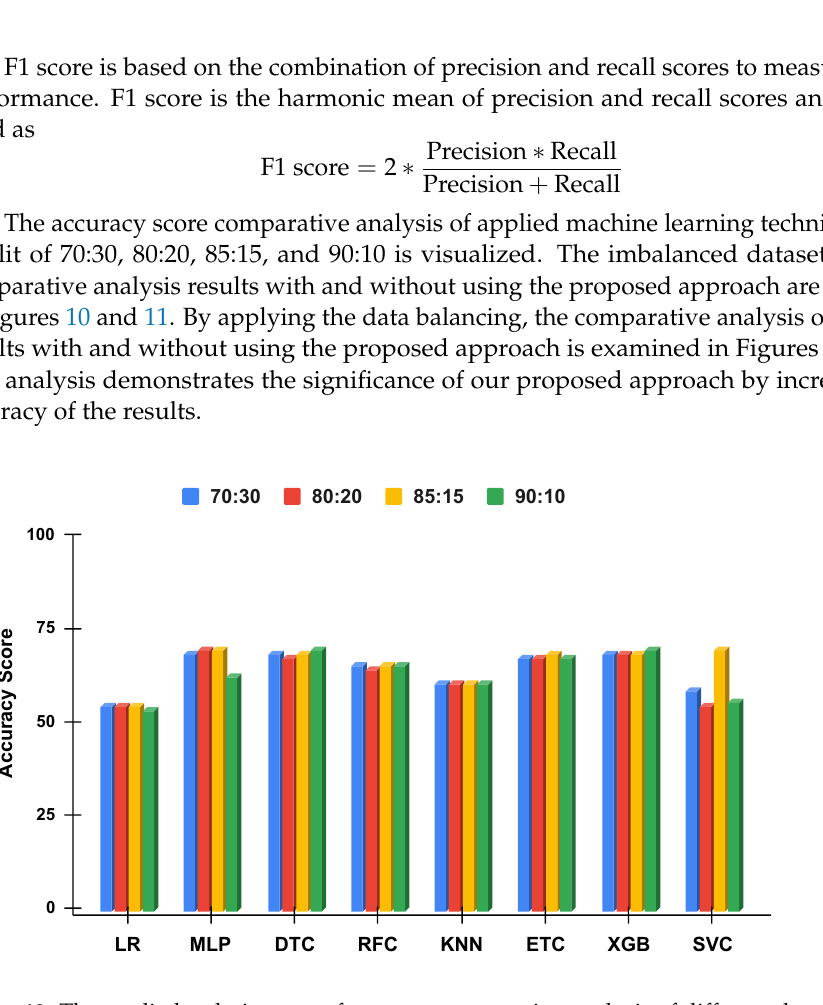
Figure 10. The applied techniques performance comparative analysis of different data split ratios without proposed technique using imbalanced data.